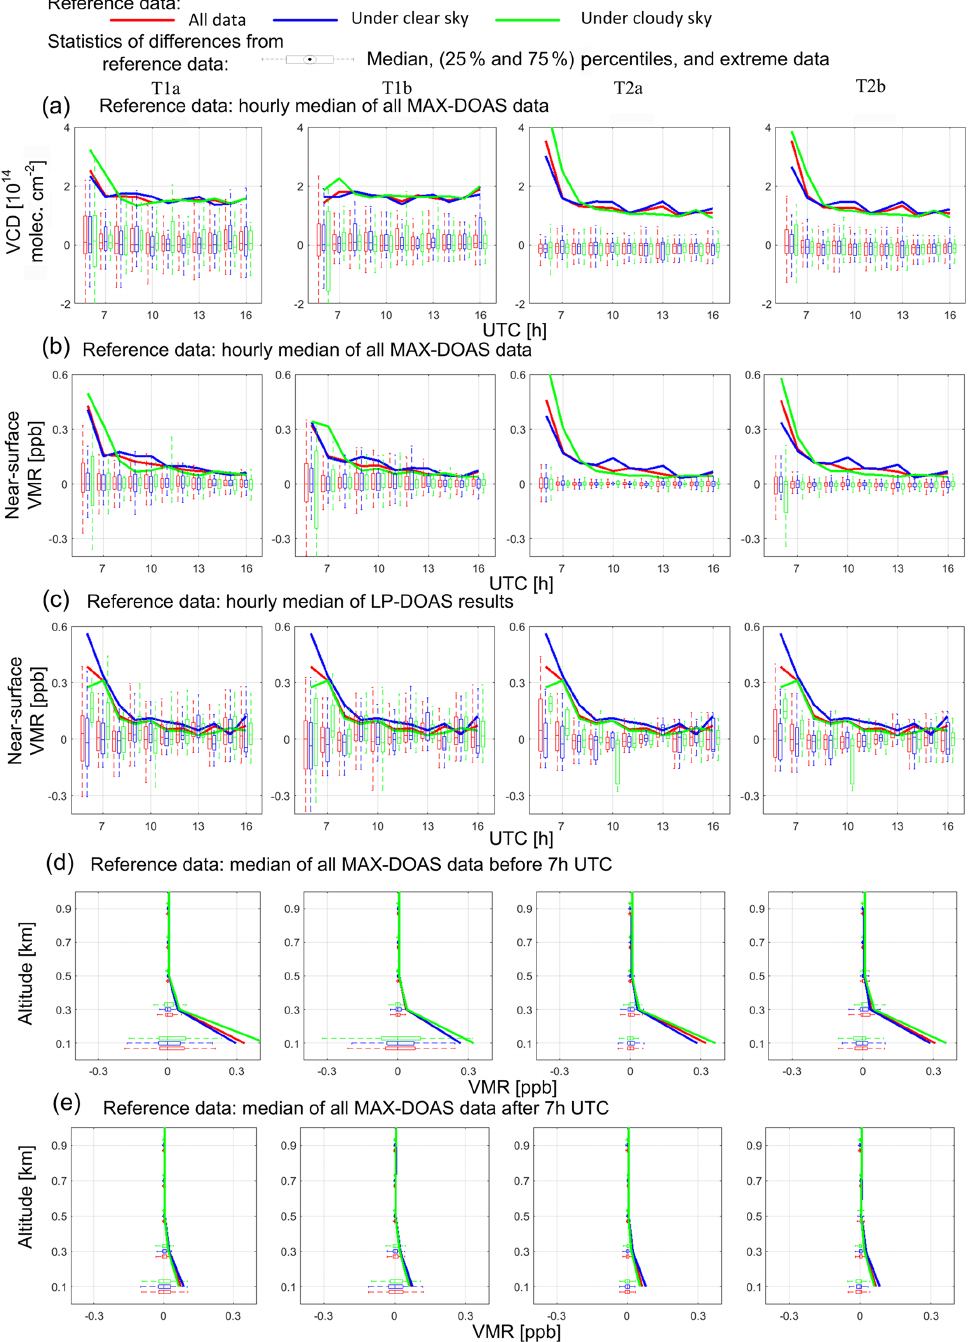
Figure 6. Boxplots of the differences of the HONO VCDs (a) , near-surface VMRs (b) , and profiles before (d) and after 07:00UTC (e) derived by different institutes compared to the median values for the whole campaign. Boxplots of the differences of the HONO near-surface VMRs compared to the co-located LP-DOAS measurements are shown in (c) . Note that the median values which served as the reference in the calculation of the boxplots are calculated in the individual time steps, namely each hour. Therefore, temporal variations of the quantities do not contribute to the boxplots. Colours in all subfigures indicate the sky condition. Comparisons of data sets for the four tasks are shown in the different columns of subfigures. Comparison results are calculated for different hours during the day in (a) , (b) , and (c) . The reference values for the comparisons are also given by the solid lines in each subfigure. The reference values are the hourly median of HONO VCDs (a) , near-surface VMRs (b) , and profiles before (d) and after 07:00UTC (e) derived from all MAX-DOAS data and near-surface VMRs derived from the co-located LP-DOAS measurements (c) ,